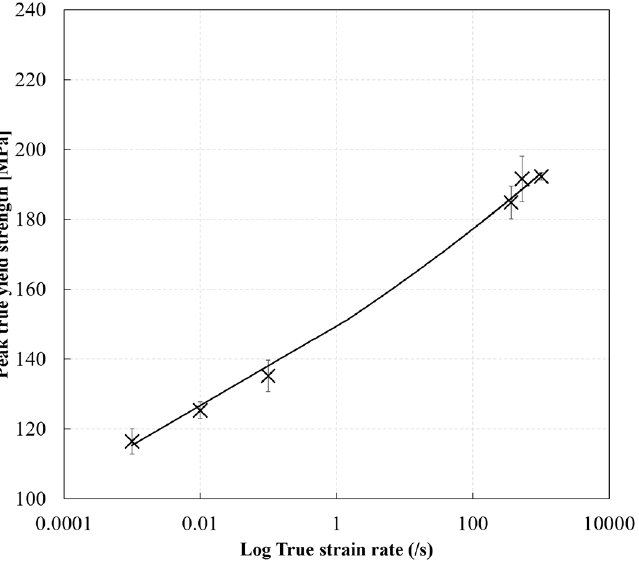
Figure 16. Effect of strain rate on the compressive peak yield strength of the RTM6 epoxy.